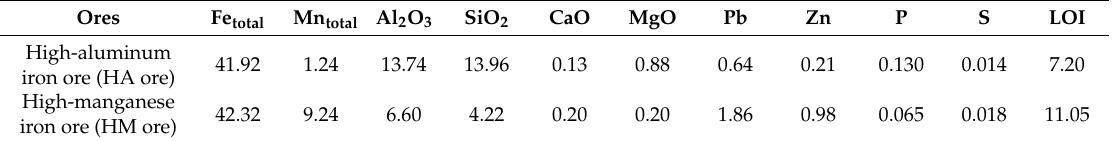
Table 1. Chemical compositions of raw materials (wt. %).